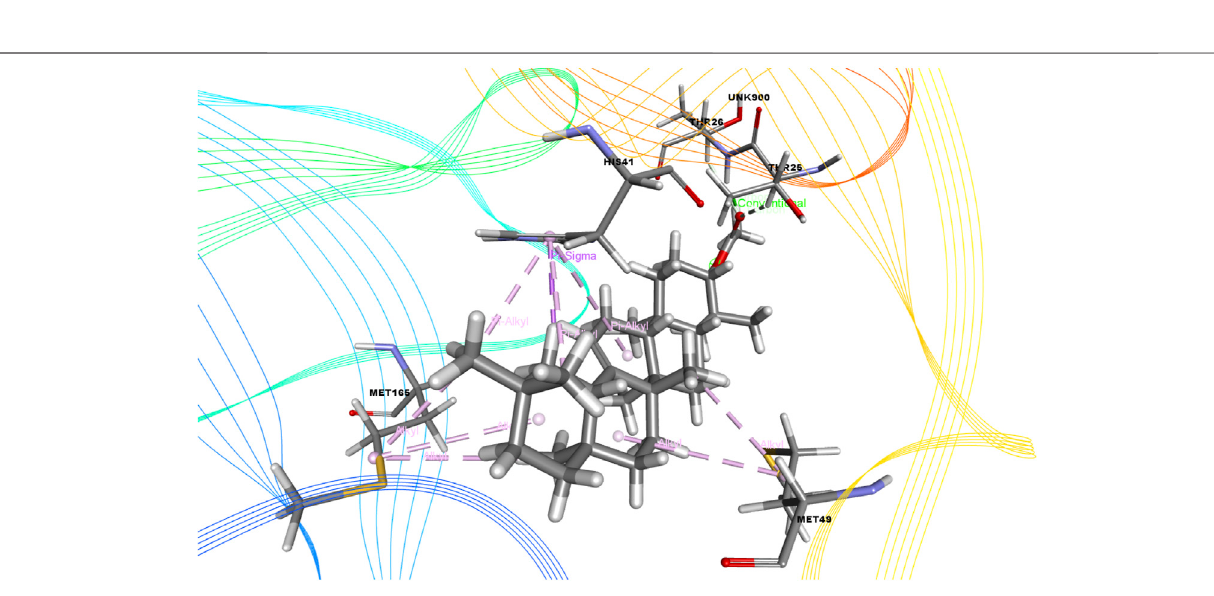
Frontiers in Molecular Biosciences |